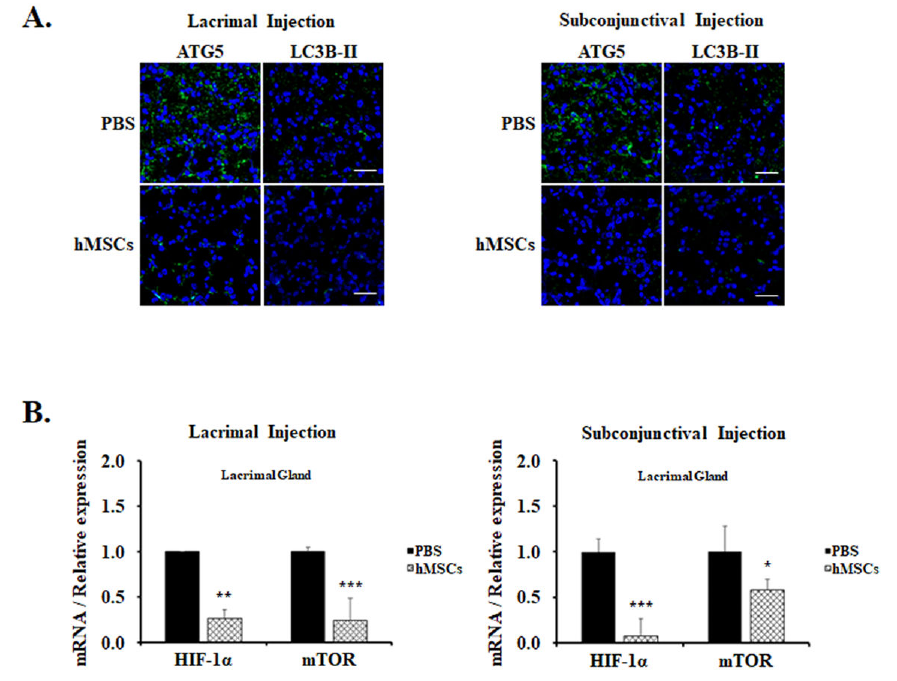
Figure 3. Autophagy expression in the LG of PBS-treated or hMSCs-treated SS mouse model. ( A ) hMSCs effects on autophagy induction shown for lacrimal glands stained with autophagy markers ATG5 or LC3B-II. Scale bar: 20 µ m. ( B ) Gene expression levels of markers related to autophagy as shown in the lacrimal glands of hMSCs or PBS-treated mice by lacrimal gland or subconjunctival injection. Data are presented from six independent experiments ( n = 6). * p < 0.05, ** p < 0.01, *** p < 0.001.